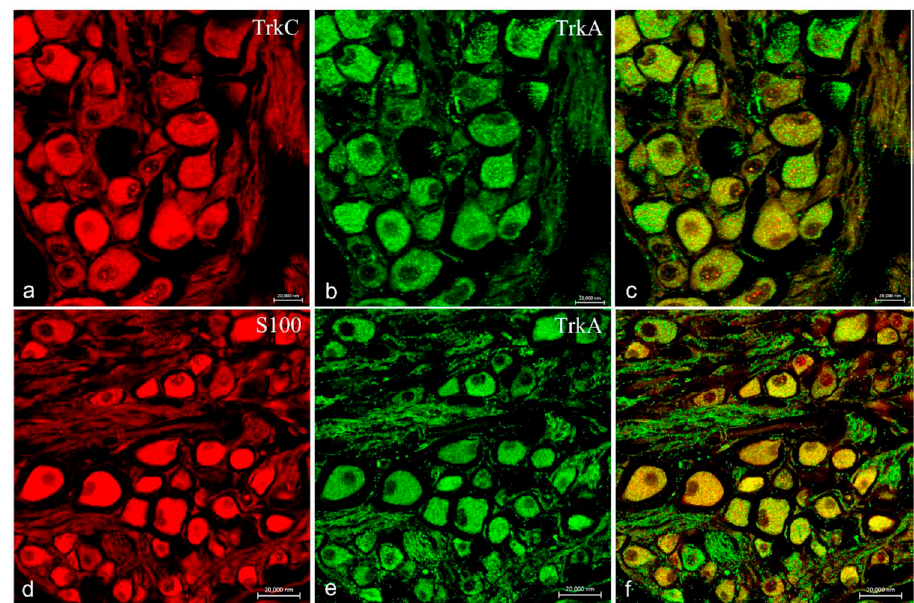
Figure 8. Ganglia of the VIII cranial nerve of N. guentheri head; transversal view. Immunohisto- chemical detection (immunofluorescence method) of trkA, trkC, and S100 protein. Immunoreactivity displayed to TrkA ( b , e ), TrkC ( a ), and S100 ( d ). Colocalization view ( c , f ) Magnification 40 × .